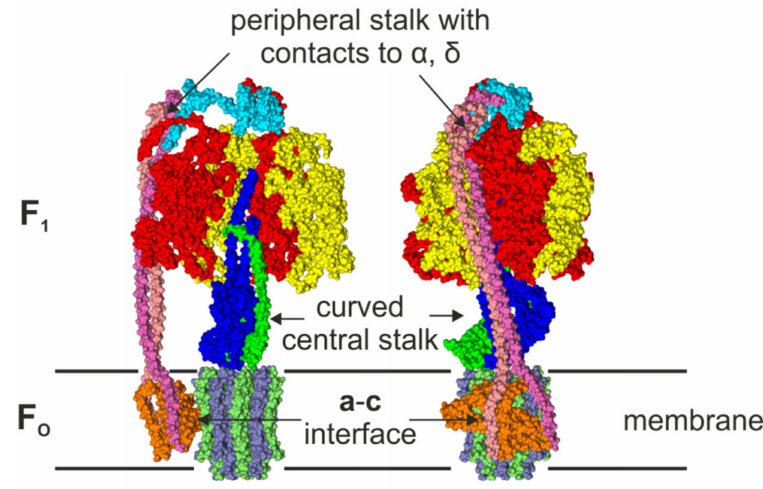
Figure 1. Front view ( left ) and side view ( right ) of a surface representation of the cryo-EM EcF O F 1 structure (PDB-id: 5T4O) [12] in the membrane. One αβ -pair is omitted in the front view to reveal the conformation of the central stalk. The structure shows the asymmetric features, i.e., the peripheral stalk that is connected to subunit δ and one subunit α , the interface of the c -ring and subunit a with its two half-channels, and the curved central shaft composed of subunits γε . The subunits are colored in red ( α ), yellow ( β ), blue ( γ ), cyan ( δ ) green ( ε ), orange ( a ), pink, and mauve ( b 2 ), and ice blue/lime ( c